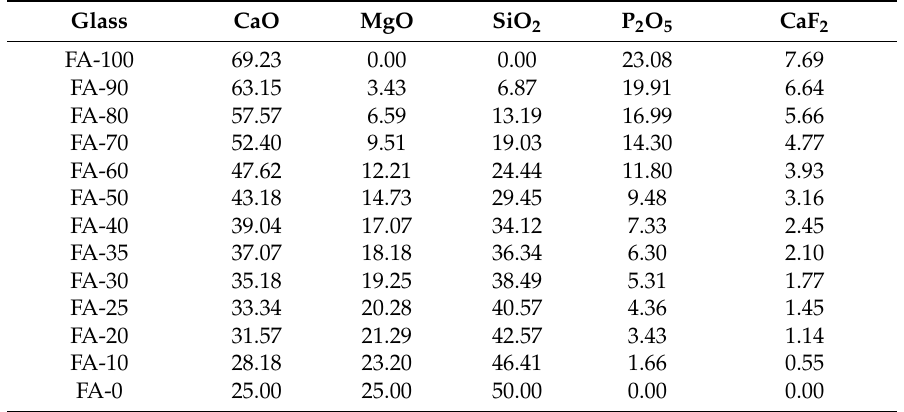
Table 9. Batch compositions of the glasses within the fluorapatite (FA)–diopside (Di) joint (mol %). Glass CaO MgO SiO